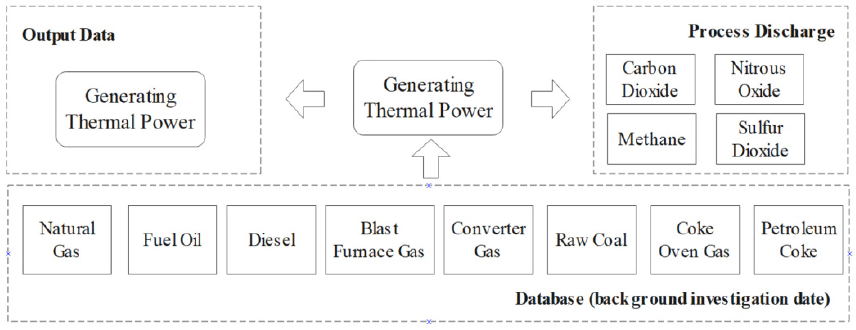
Figure 7. System boundary of thermal power.